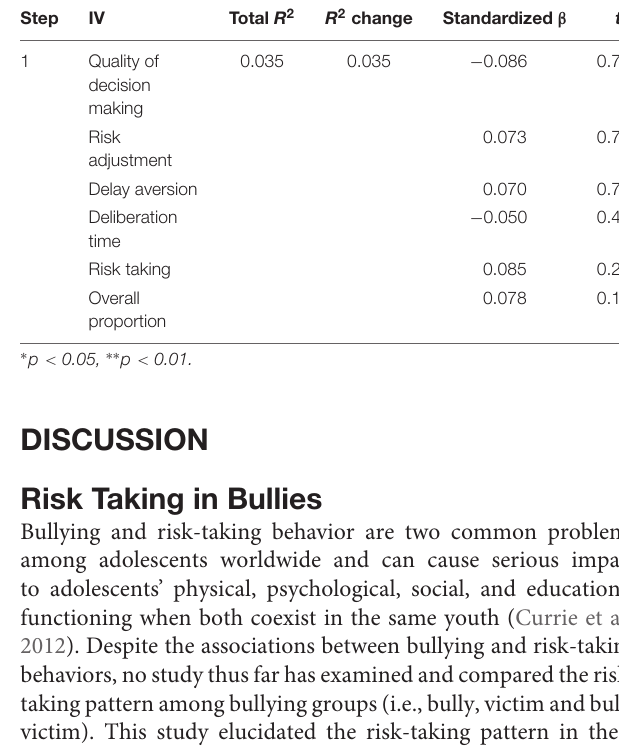
TABLE 10 | Hierarchical regressions predicting CGT variables among victim